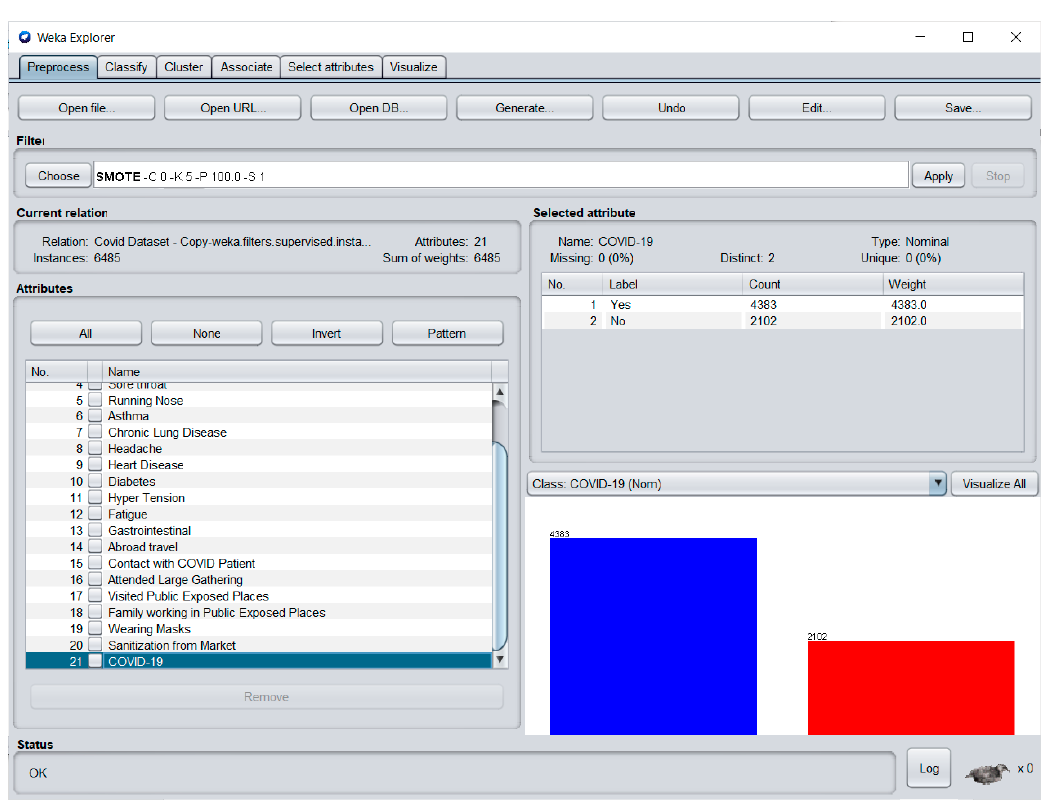
Figure 4. The Preprocess tab of WEKA Explorer showing the result of balancing the dataset through SMOTE using a bar graph for representing the number of instances per class.